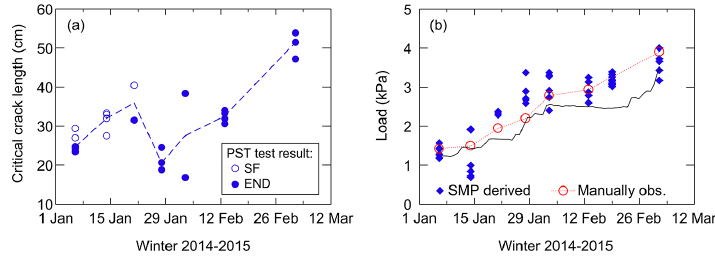
Figure 2. (a) Critical cut length as observed in propagation saw tests (number of cases: N = 24). Full circles indicate crack propagation to the very end of the column (END), while open circles indicate partial propagation resulting in a fracture across the slab (SF); the dashed line connects the median values per day. (b) Load on the weak layer: red open circles (connected by dotted line) show the load as calculated from the manually observed density and layer thickness; blue diamonds are corresponding SMP-derived values ( N = 48). The black solid line indicates the load as provided by